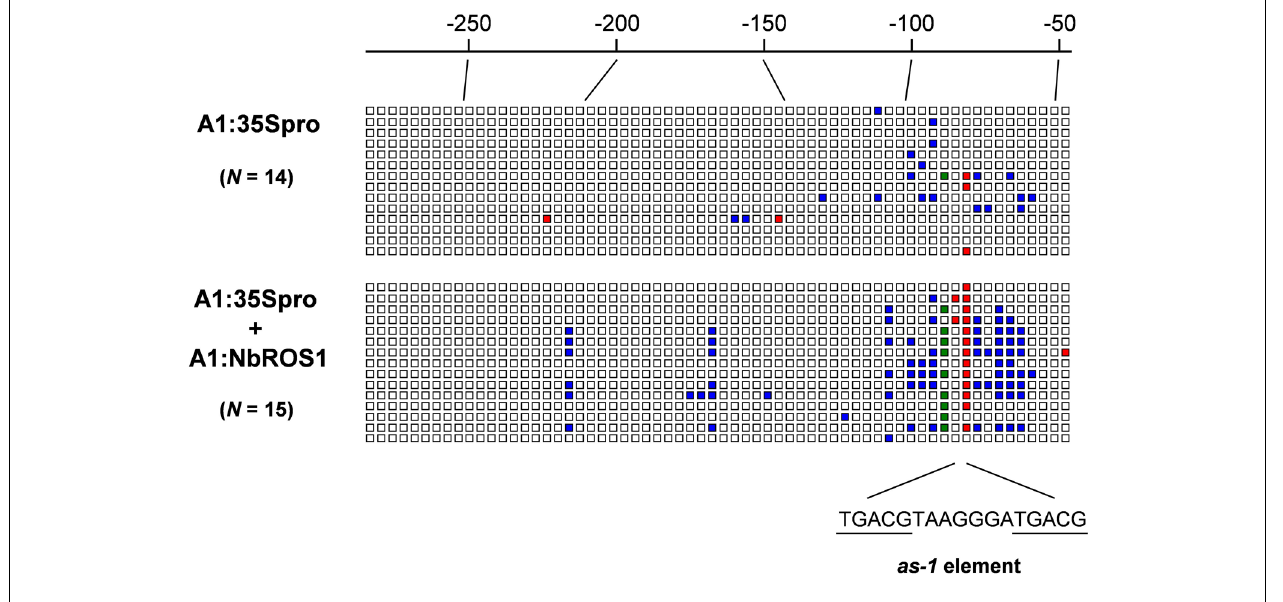
indicate methylcytosines at the CG, CHG, and CHH sites, respectively. Numbers on the line indicate nucleotide positions relative to the transcription start site of the CaMV 35S promoter.The position of the cis -acting as-1 element, to which binding of protein factor(s) is inhibited by cytosine methylation (Kanazawa etal., 2007b), is shown below the